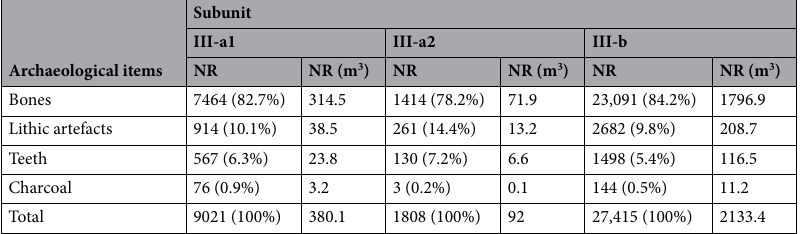
Table 2. Number of archaeological items from subunits III-a1, III-a2 and III-b. NR number of